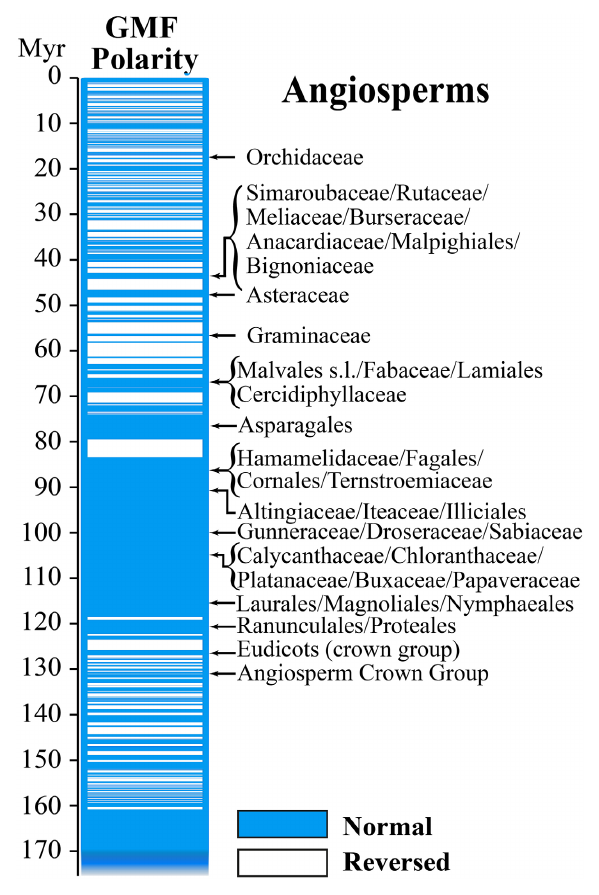
FIGURE 2 | Geomagnetic field reversals and Angiosperm evolution. In the direct comparison of GMF polarity and diversion of Angiosperms it is interesting to note that most of the diversion occurred during periods of normal magnetic polarity (Modified from Occhipinti et al.,